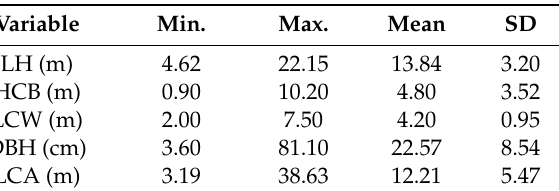
Table 1. Descriptive statistics of tree measurements (SD, standard deviation).